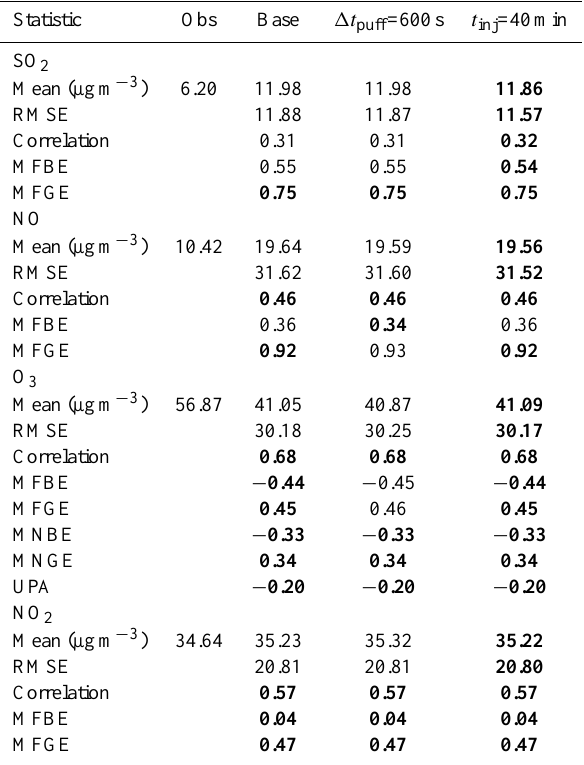
Hourly statistics: comparison between (1) Base